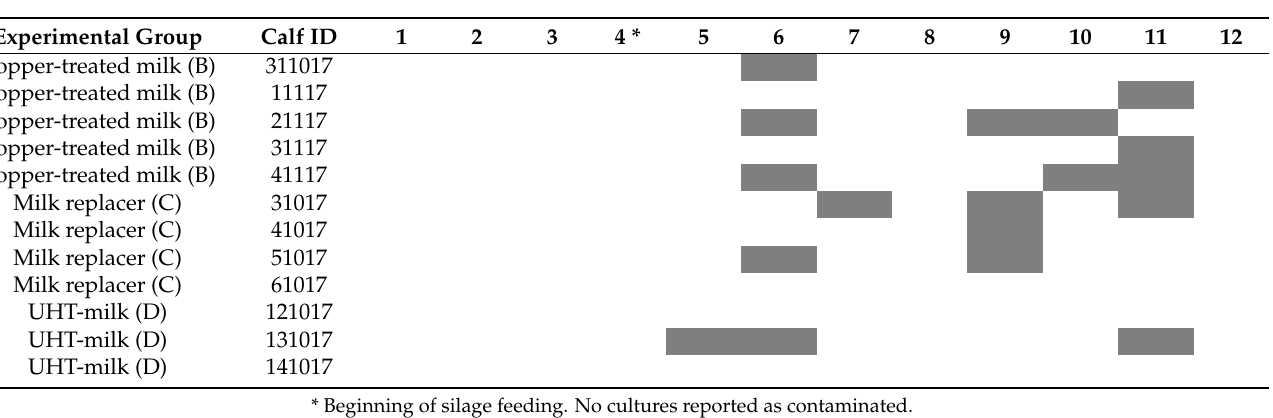
Table 3. Mean plasma copper (Cu) concentrations, plasma activity of liver enzymes glutamate dehydrogenase (GD), gamma-glutamyl transferase (GGT), and aspartate aminotransferase (AST) and hepatic copper concentrations, per exper- imental group during the experimental period (mean ± standard deviation of 9 monthly samples). The reference intervals are shown in parentheses.